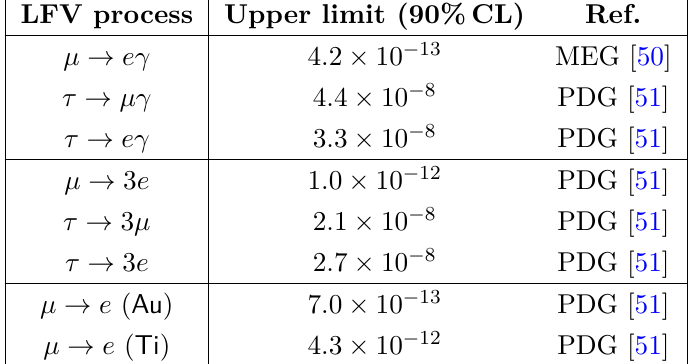
Table 2 . Upper limits on the branching ratios/conversion rates of various lepton flavour violation (LFV) processes at 90% CL. Here µ → e refers to conversion rate in gold ( Au ) and titanium ( Ti